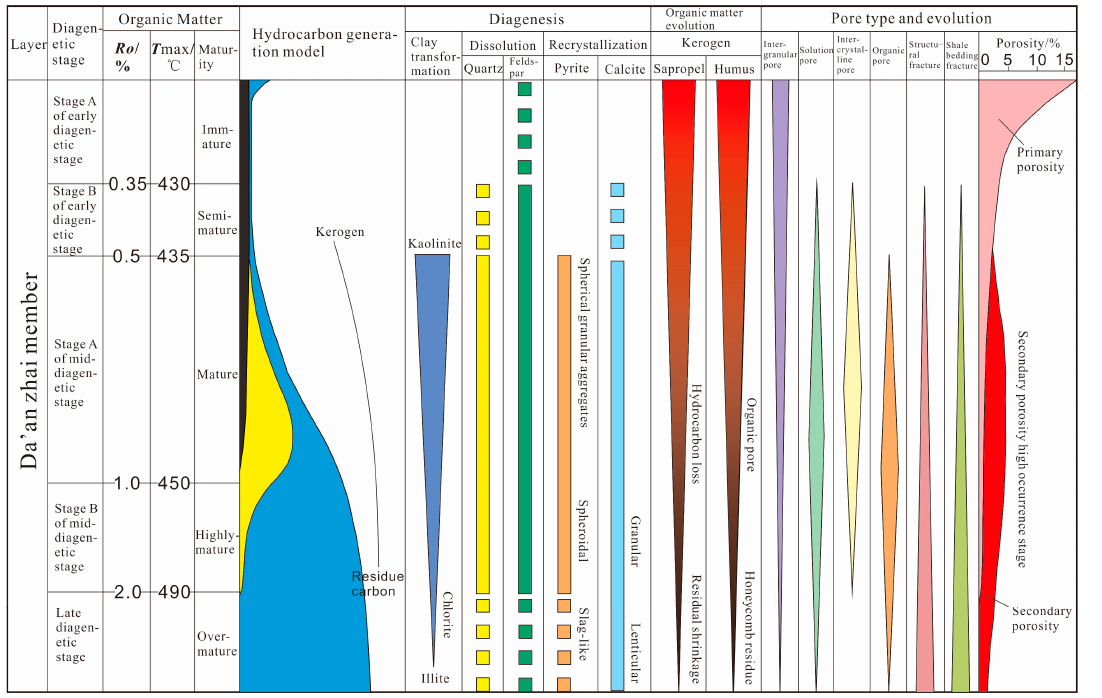
Figure 9. Diagenetic evolution and pore evolution model of Da’anzhai shale in the Sichuan Basin.